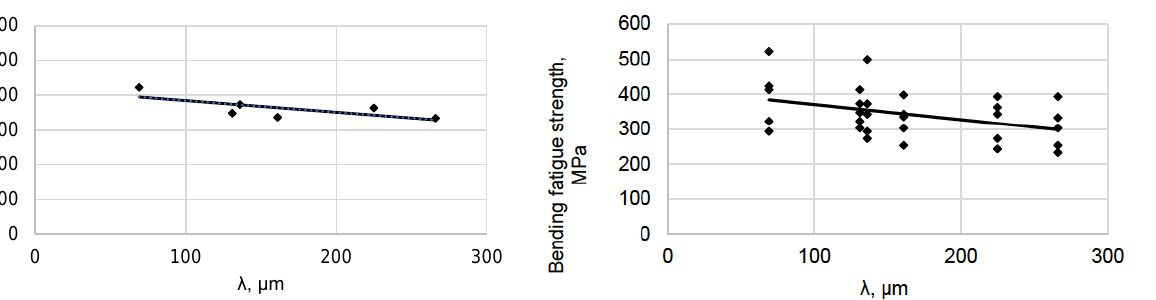
Figure 2: Bending fatigue strength of steel hardened and tempered at 300 ∘ C subject to impurities space